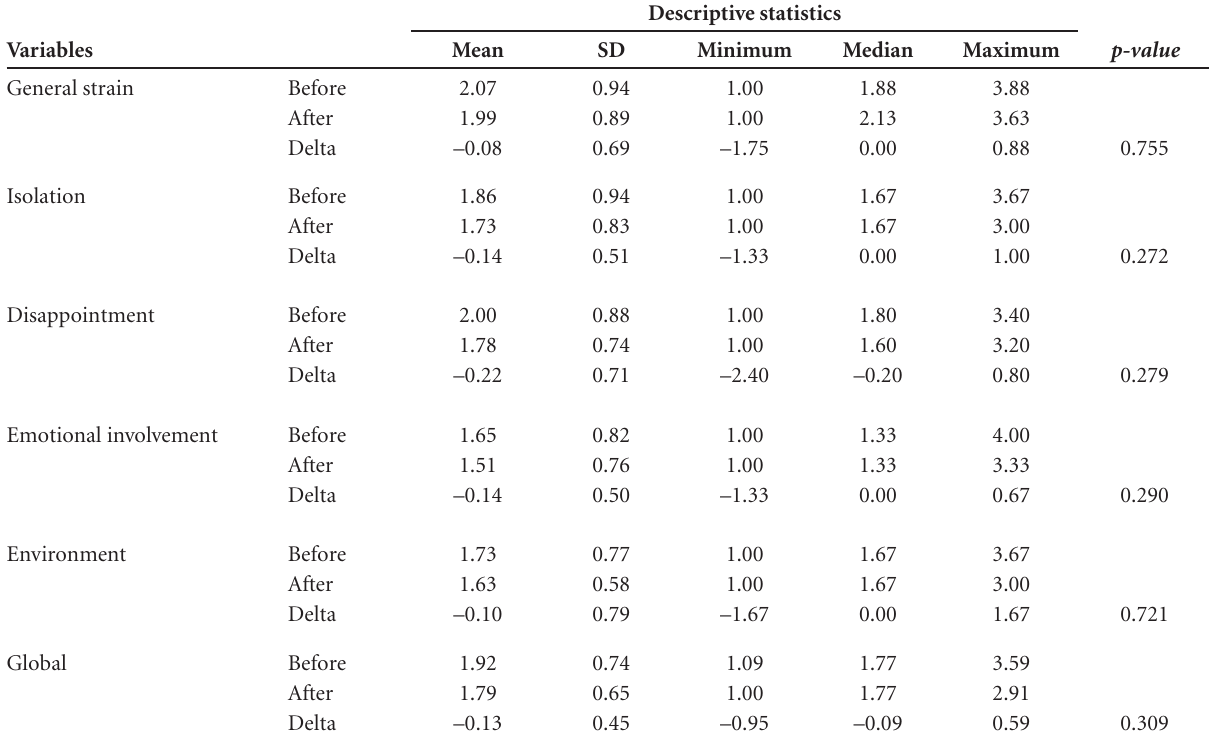
Table 3. Results on Wilcoxon tests for related samples comparing total and domain scores on Caregiver Burden Scale, before and after psychoeducation